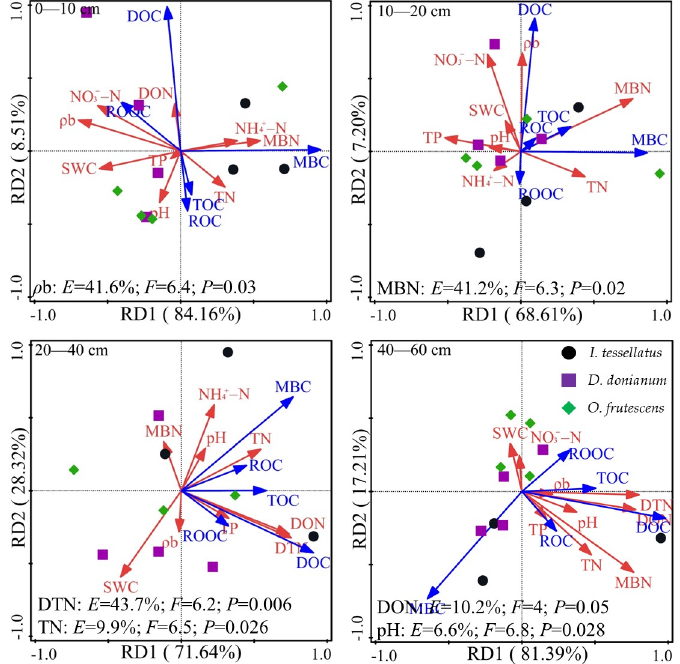
Figure 5. Redundancy analysis of soil organic carbon and its components with physicochemical properties. SWC (Soil moisture content); ρ b (Bulk density); pH (pH); TN (Total nitrogen); TP (Total phosphorus); NH 4+ − N (Ammonium); NO 3 − − N (Nitrate); DTN (Dissolved total nitrogen); DON (Dis- solved organic nitrogen); MBN (Microbial biomass nitrogen); TOC (Total organic carbon); ROC (Re- calcitrant organic carbon), ROOC (Readily oxidizable organic carbon); MBC (Microbial biomass car- bon); DOC (Dissolved organic